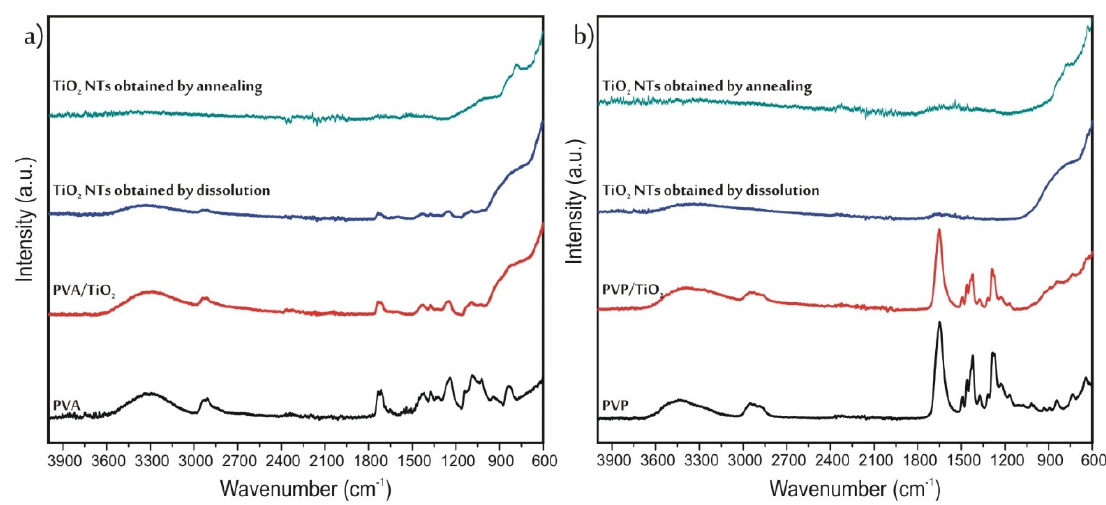
Figure 4. ATR-IR results of the samples prepared from ( a ) PVA, ( b ) PVP.